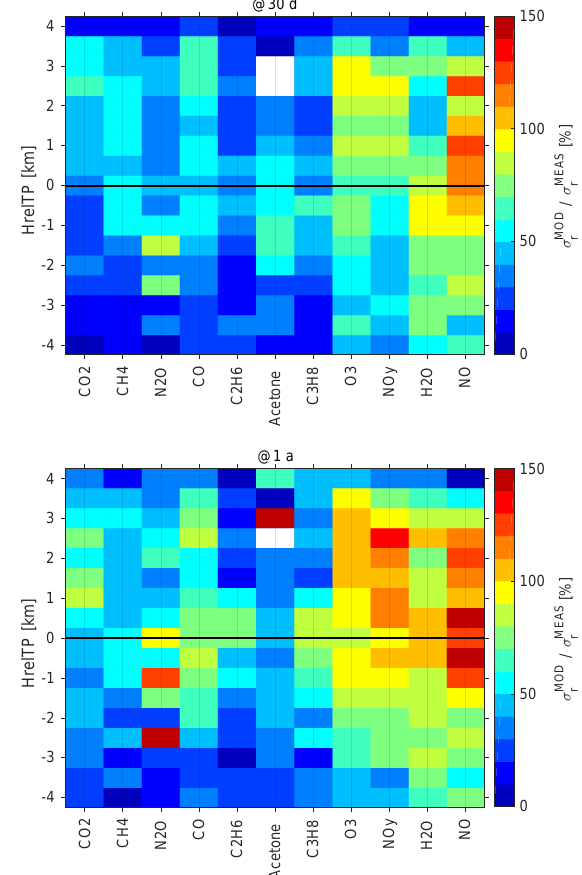
Figure 6. σ MOD r /σ MEAS r given in percent for timescales of 30 days (top) and 1 year (bottom), where MOD stands for MOD sampled CARIBIC and MEAS stands for MEAS smoothed . Values greater than 50% in- CARIBIC dicate the high model